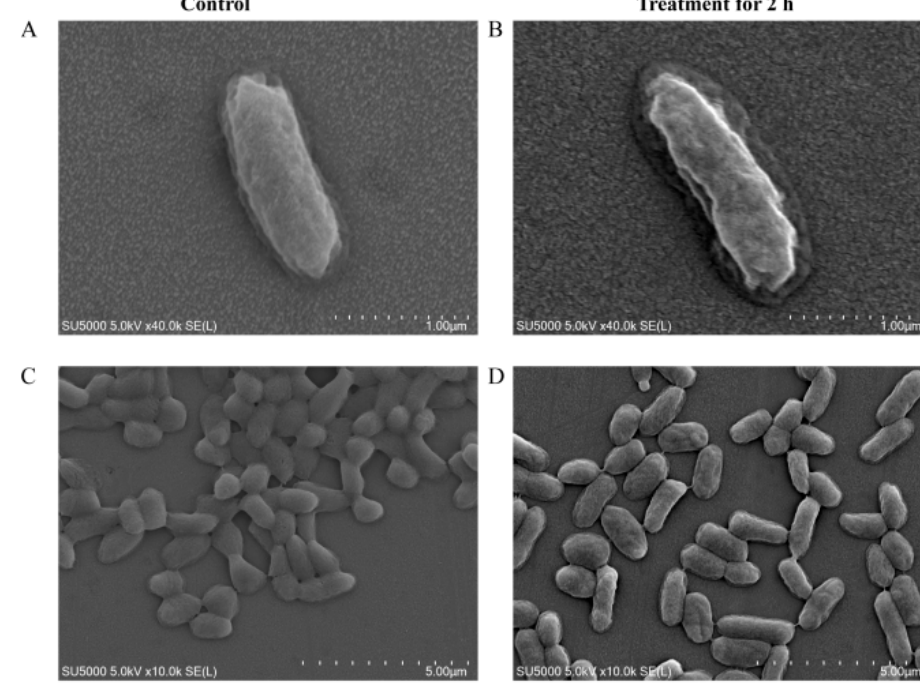
Figure 7. The SEM observation of cell surface structure of V. parahaemolyticus N10-18 under Cd 2+ (50 μ g/mL) stress. ( A , C ) The control groups with 0 μ g/mL of Cd 2+ (observed by ×40.0 k, and ×10.0 k). ( B , D ) The treatment groups with 50 μ g/mL of Cd 2+ (observed by ×40.0 k, and ×10.0 k). 3.10. The Major Changed Metabolic Pathways Medicated by the Cd 2+ (50 μ g/mL) Stress in V. parahaemolyticus N10-18